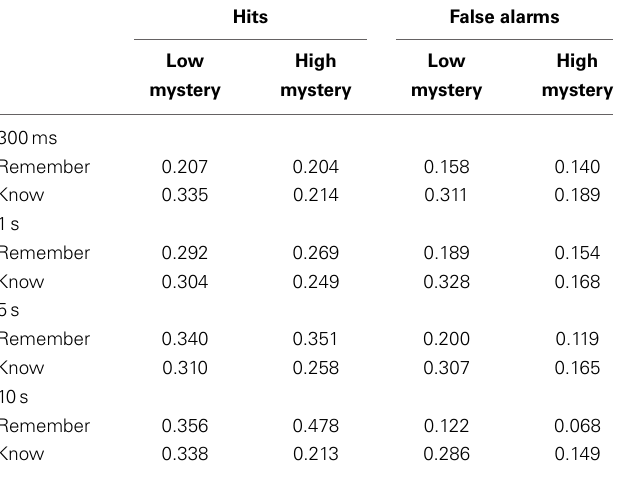
Table 2 | Response probability as a function of presentation duration and scene type.